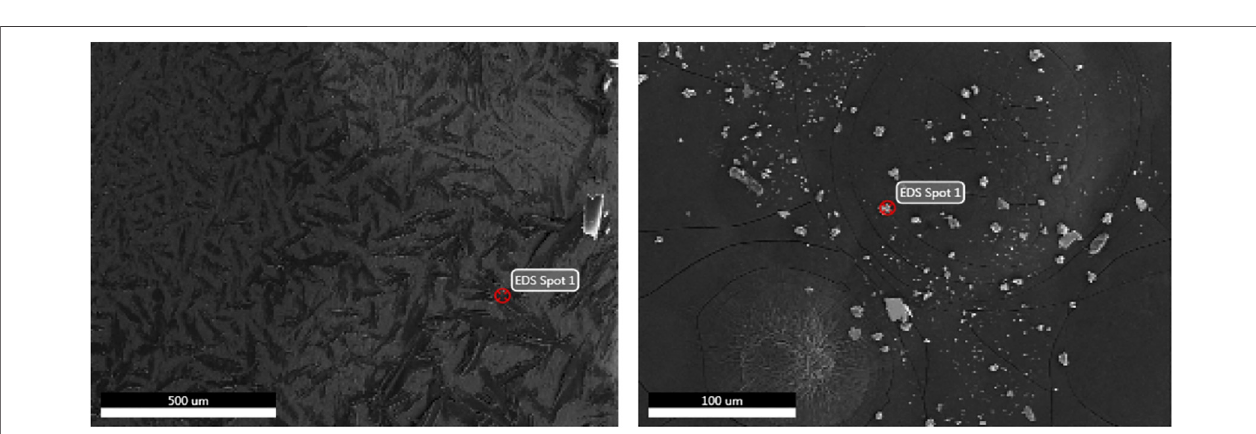
Frontiers in Chemistry |